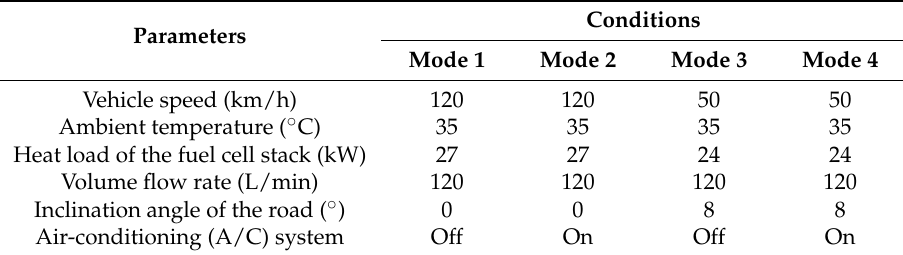
Table 3. Parameters used during simulation of the stack cooling